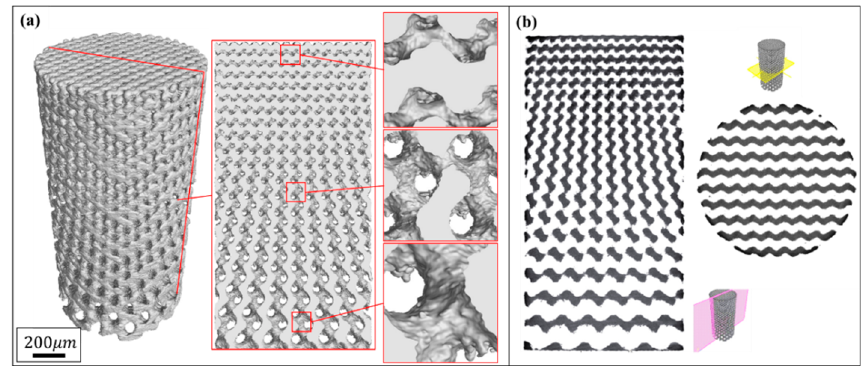
Figure 3. ( a ) Micro-computer tomography CT) reconstruction models of Gyroid cell-size gradient samples with different magnifications, and ( b ) corresponding 2D slice images.